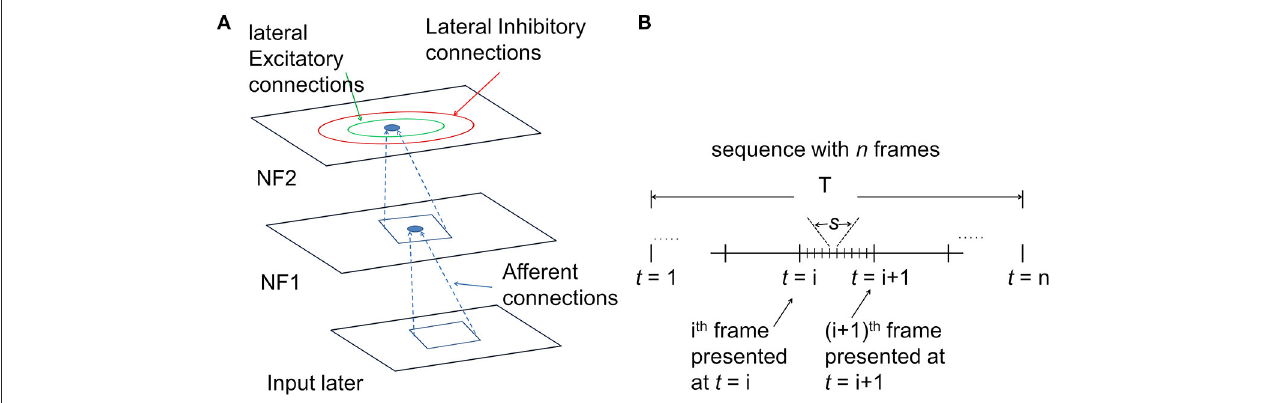
FIGURE 1 | The architecture of the motion processing system. (A) Neural field Model: It consists of two NFs, analogous to V1 and MT of the visual cortex. Input layer represents the receptor surface such as the retina. Each NF is organized as a two-dimensional array of neurons with lateral connections. Every neuron has excitatory afferent (incoming; shown in dotted lines) connections from units in their square-shaped RF. Neighboring neurons have overlapping RFs. In addition, every neuron receives inputs from two types of lateral connections: excitatory connections (green circle represents excitatory radius) with nearby neighbors and inhibitory with neurons farther away (red circle represents inhibitory radius). (B) the timeline of input sequence presentation to the network : The model response to a moving stimulus was simulated at two different time scales. The sequence of n frames was presented to the network over a period of time T . Motion within the stimulus sequence was generated at several discrete time steps “t.” The number of time steps is equal to the number of frames within the sequence. For a given time “ t ” the lateral interactions were allowed to proceed for several time steps “ s ,” called the settling time .